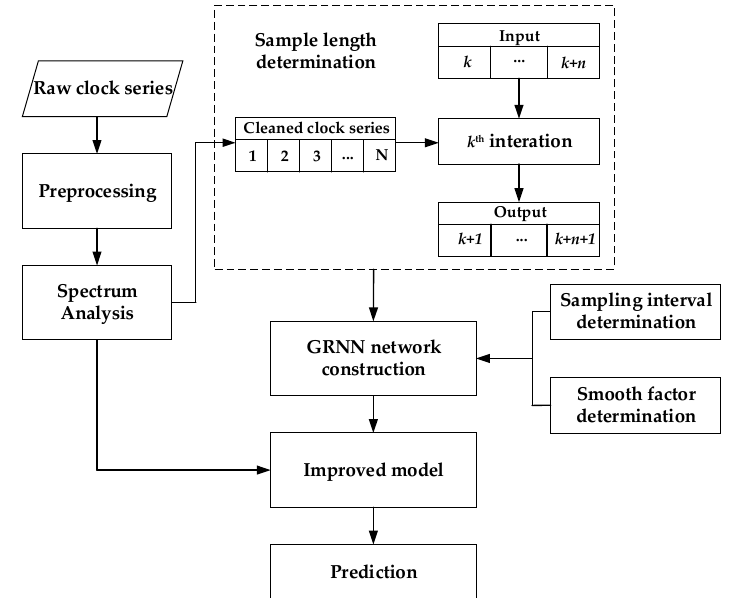
Figure 2. Data processing diagram for the improved model.